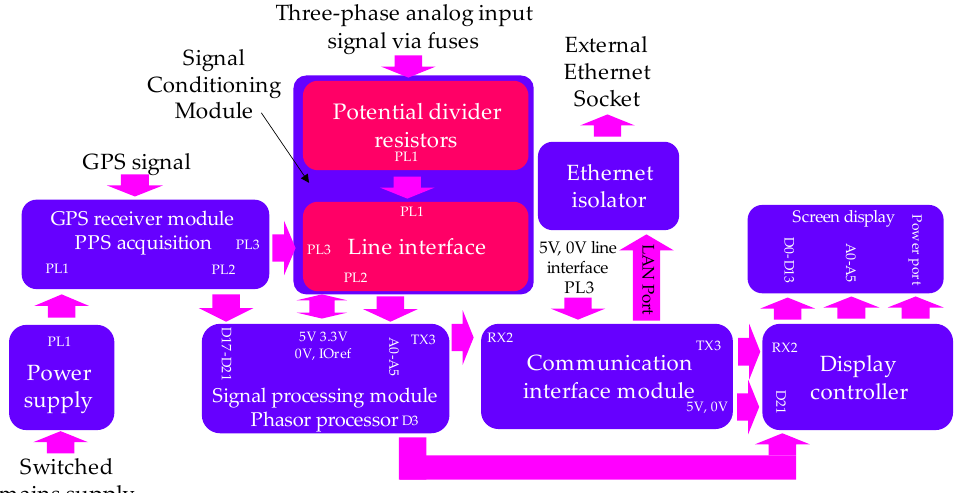
Figure 5. Block diagram showing the proposed PMU implementation, identical to the one devel- oped in this scientific paper. Arrows show the direction flows of signals. Ports are indicated at relevant blocks.